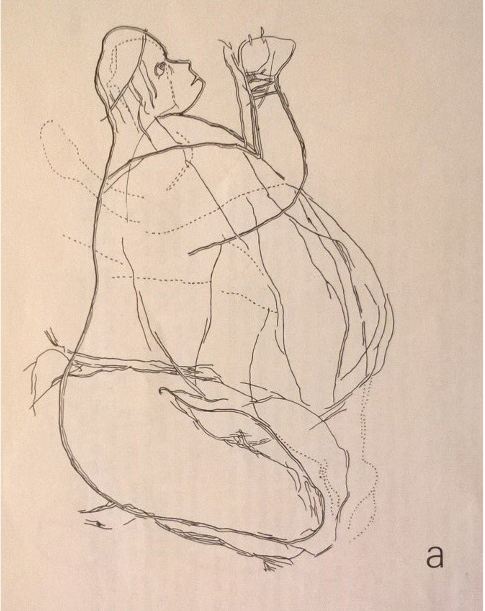
Figure 8. Group α, examples of Hand α1: Obs. 40(I) (from Pales,